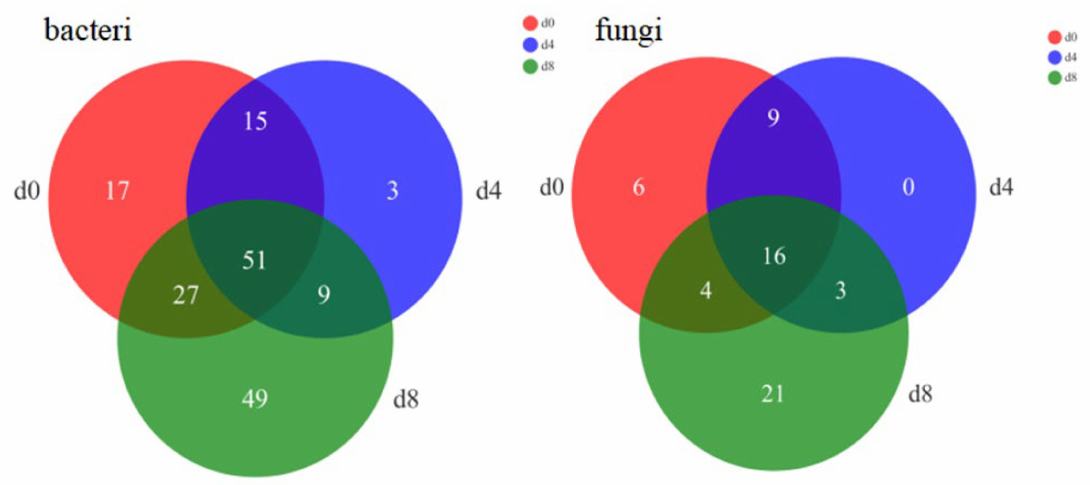
Figure 4. Venn analysis of OTU distribution of vinasse